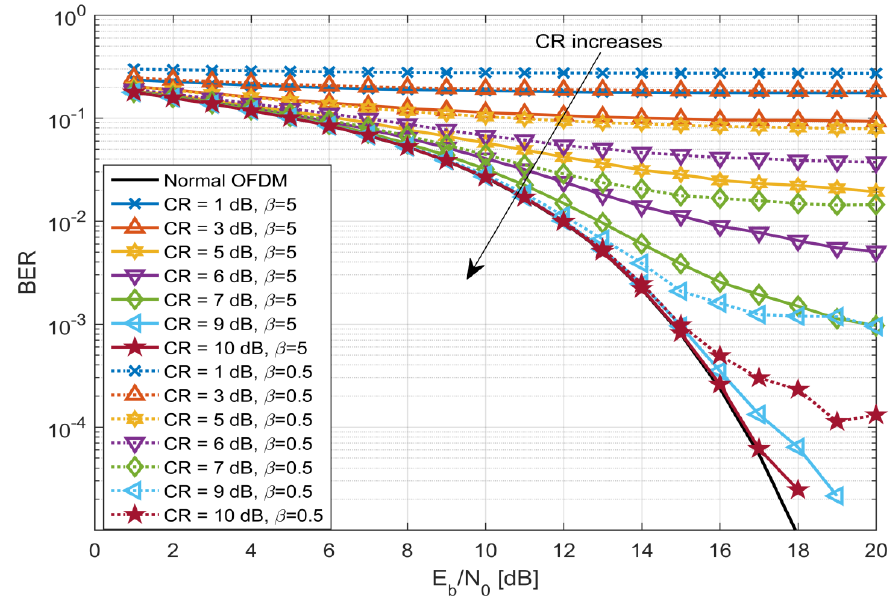
Figure 17. BER performance of the PC method with variable CR, N = 64, and the 16-QAM over the AWGN channel. modulation over the AWGN channel.